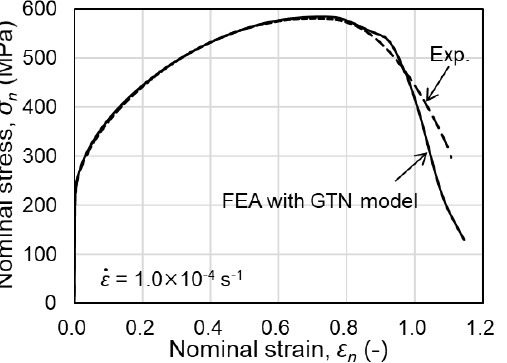
Fig. 3. Comparison between measured and simulated result obtained using GTN